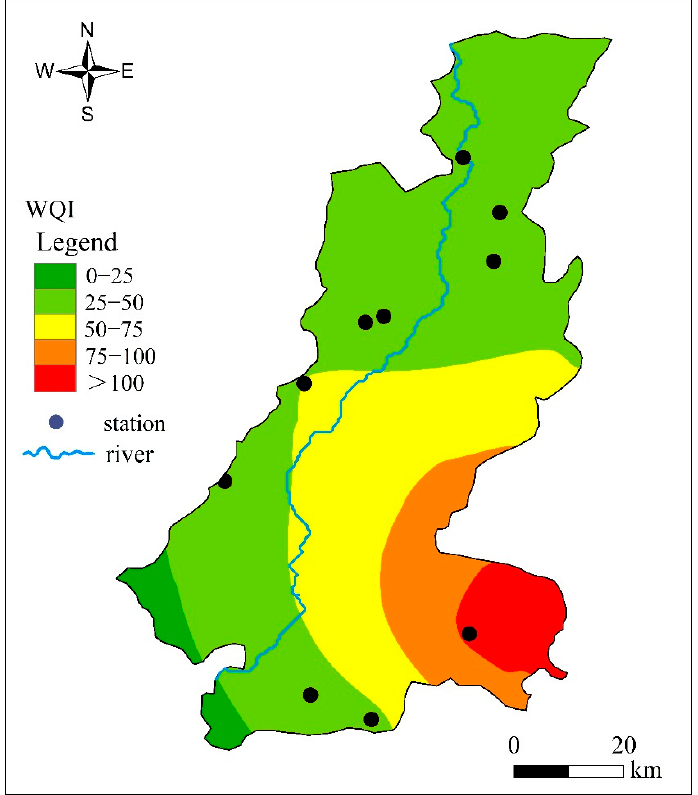
Figure 3. Spatial distribution of groundwater quality based on water quality index values.